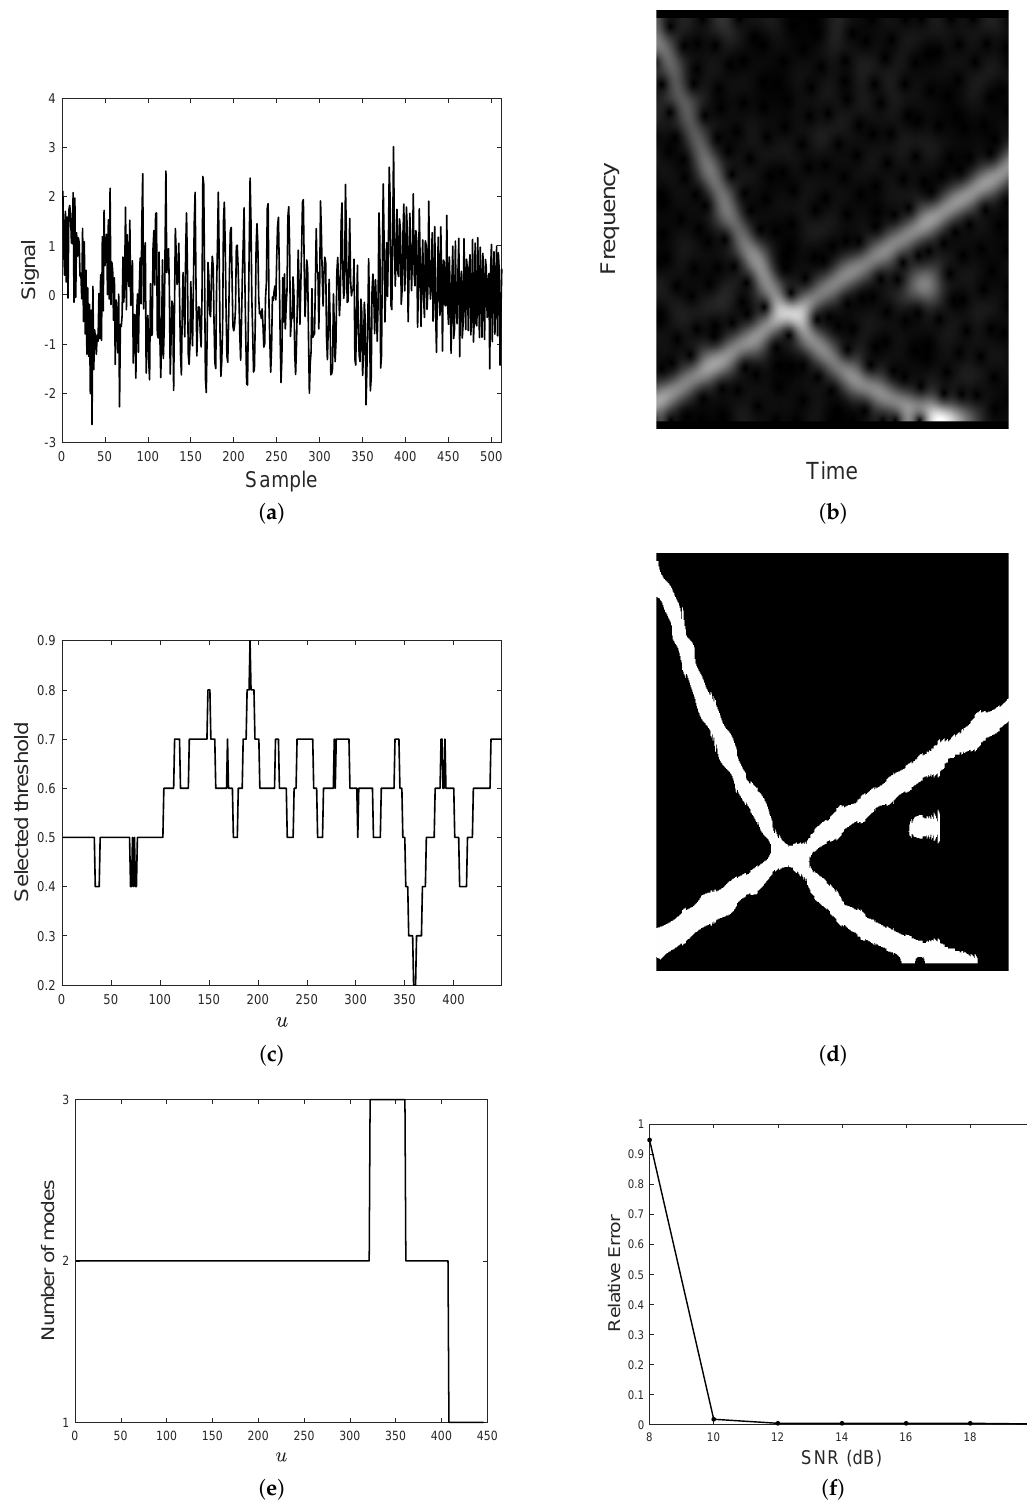
Figure 16. ( a ) AM–FM signal composed of three components embedded with AWG noise, SNR = 10 dB. ( b ) Spectrogram of ( a ), s = 64. ( c ) Optimal threshold provided by MDL functional minimization, according to Equation (18). ( d ) Binary map derived from ( b ). ( e ) Estimated number of modes. ( f ) Relative counting error against